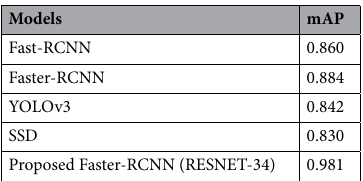
Table 5. Comparative analysis of the presented method DL-based approaches.